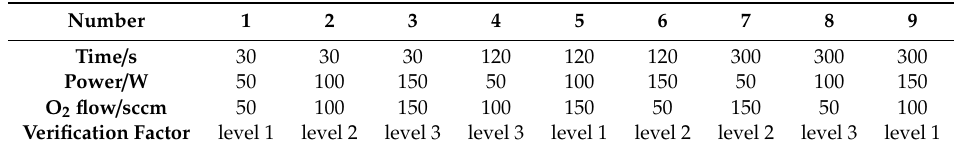
Table 1. L9 (3 4 ) orthogonal experiment design.